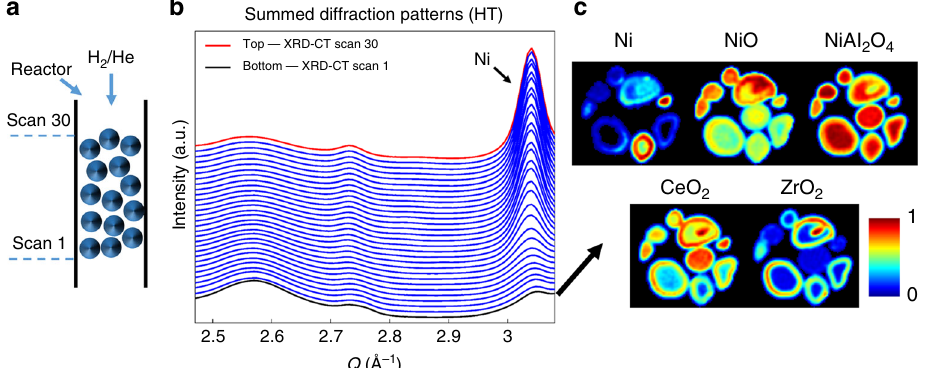
Fig. 4 Reduction and activation of the catalyst bed. a Schematic representation illustrating the initial and fi nal probing position during the 3D-XRD-CT at 800 °C under 20% H 2 /He fl ow. The gases were introduced into the reactor from the top as indicated by the blue arrows. b The summed diffraction patterns of the 3D-XRD-CT data (30 XRD-CT scans). The black arrow indicates the highest intensity Ni peak. c Phase distribution maps of Ni, NiO, NiAl 2 O 4 , CeO 2 and ZrO 2 corresponding to the normalised scale factors of these phases as derived from the Rietveld analysis of XRD-CT scan 1 as indicated by the black arrow